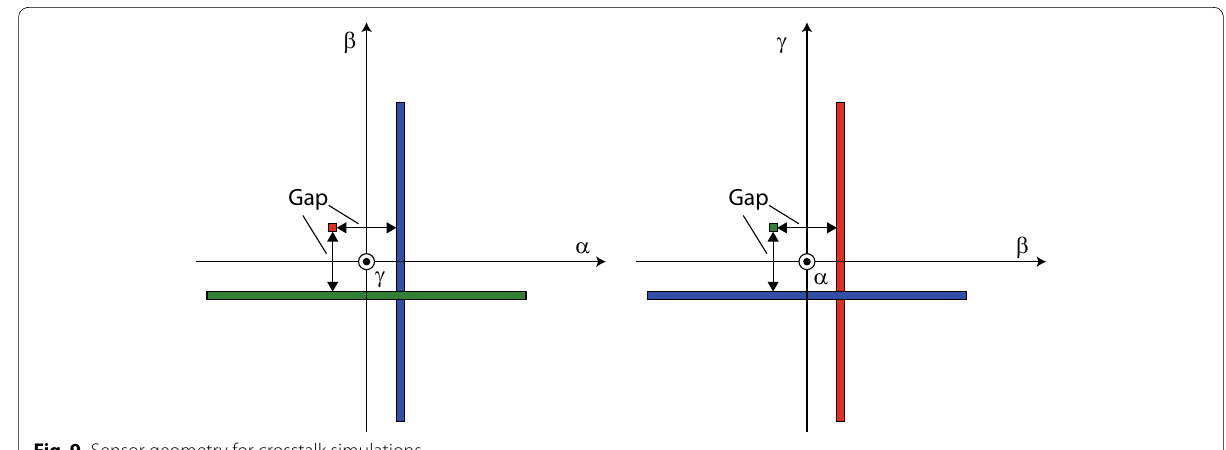
Fig. 9 Sensor geometry for crosstalk simulations